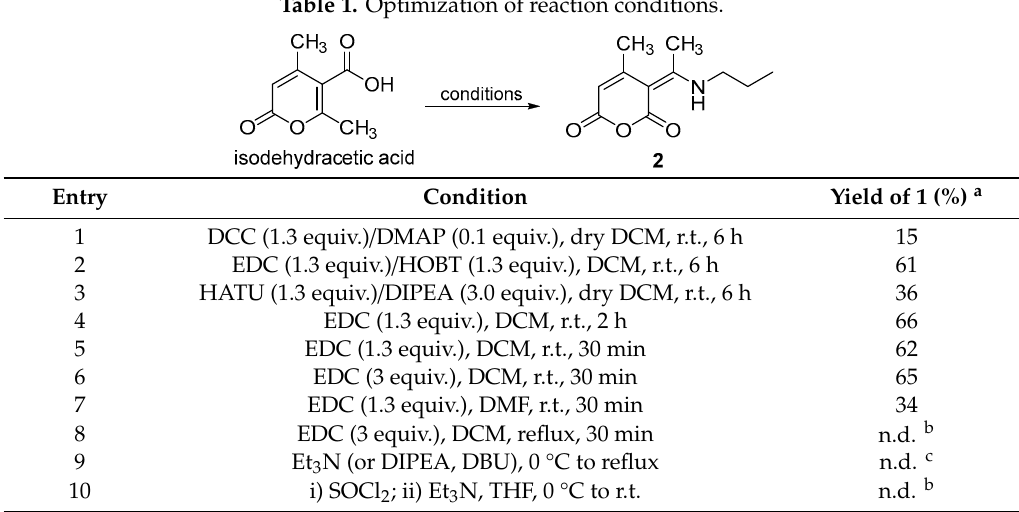
Figure 3. X-ray crystal structure of compound 3 . Table 1. Optimization of reaction Table 1. Optimization of reaction conditions.